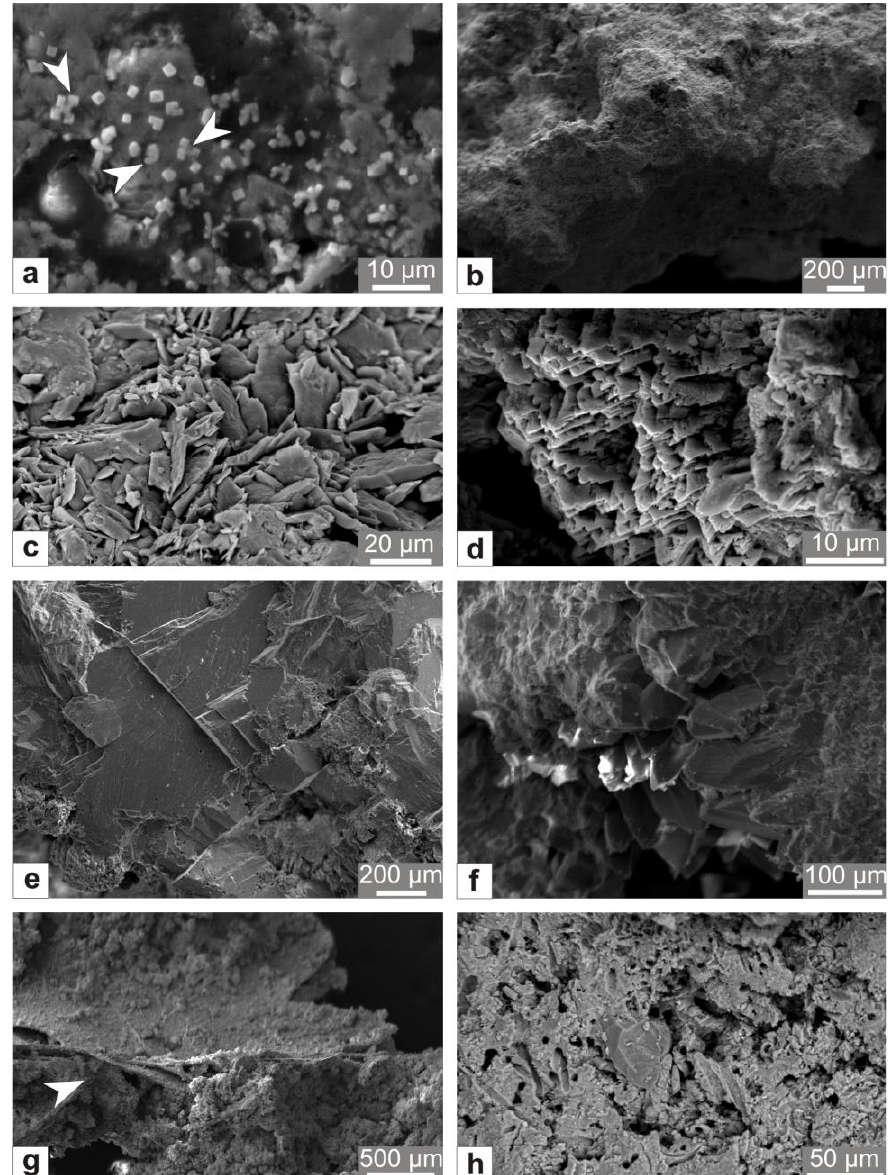
Figure 5. SEM images of tufa samples. ( a ) White arrows point to sylvite crystals; ( b ) Massive calcite aggregate in algal tufa; ( c ) Crystals of a primitive rhombohedron in moss tufa; ( d ) Dagger-like calcite crystals in moss tufa; ( e ) Massive calcite aggregate with well-developed cleavage; ( f ) Scalenohedron calcite crystals; ( g ) Phytoclastic tufa. Note the leaf imprint (white arrow); ( h ) Tubular cavities in calcite left by loss of bacterial filaments.